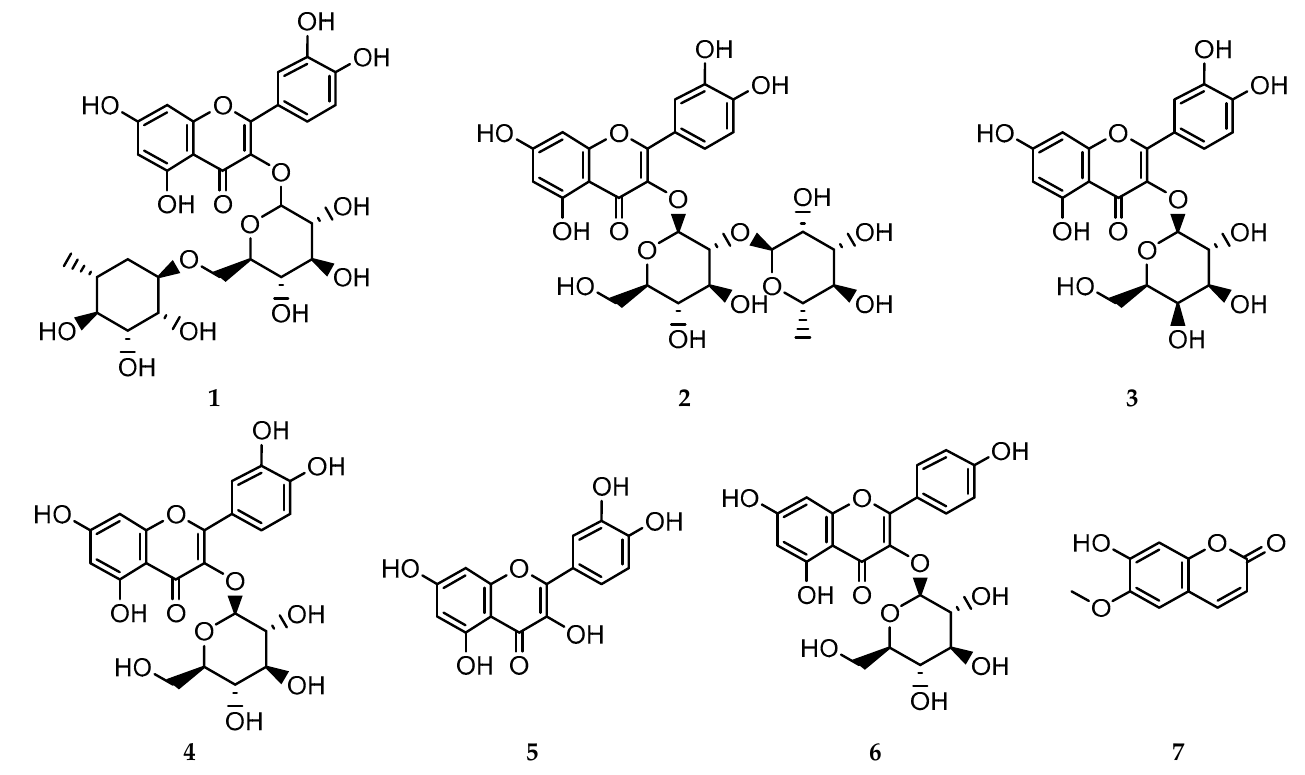
Figure 1 . Structure of isolated compounds 1 – 7 . Figure 1. Structure of isolated compounds 1 – 7